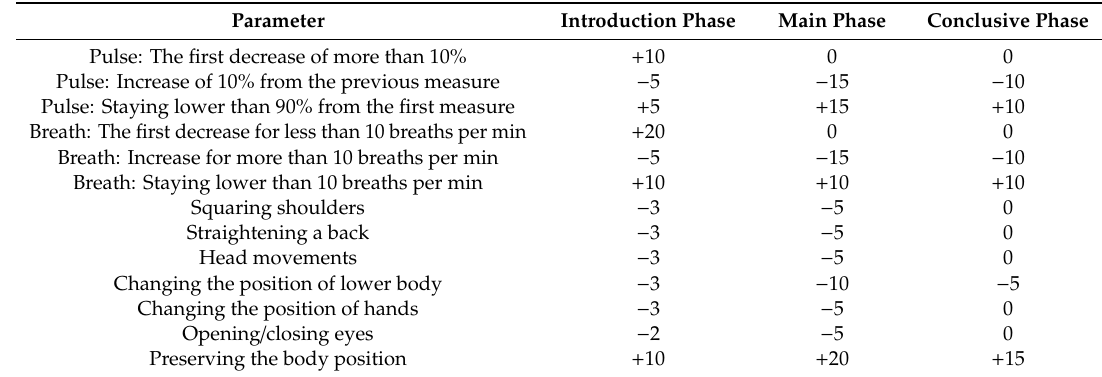
Table 2. Defined features and their grades.